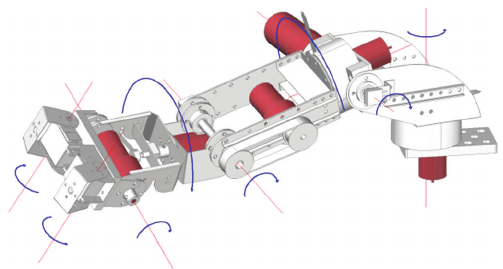
Figure 2: CAD diagram of the 6-DOF robotic arm and gripper. The 6 dark cylinders are DC motors, each accommodating a degree of